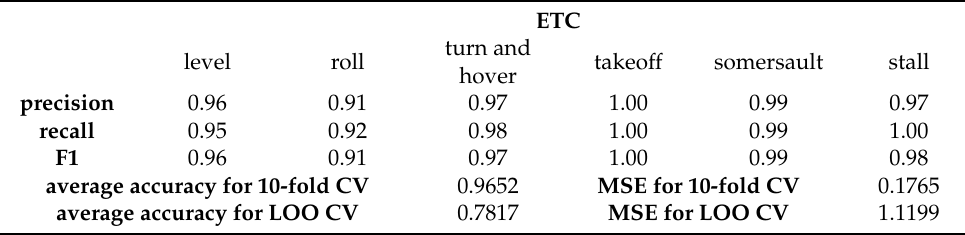
Figure 7. The confusion matrix of classifiers. Table 8. The classification report of classifiers.